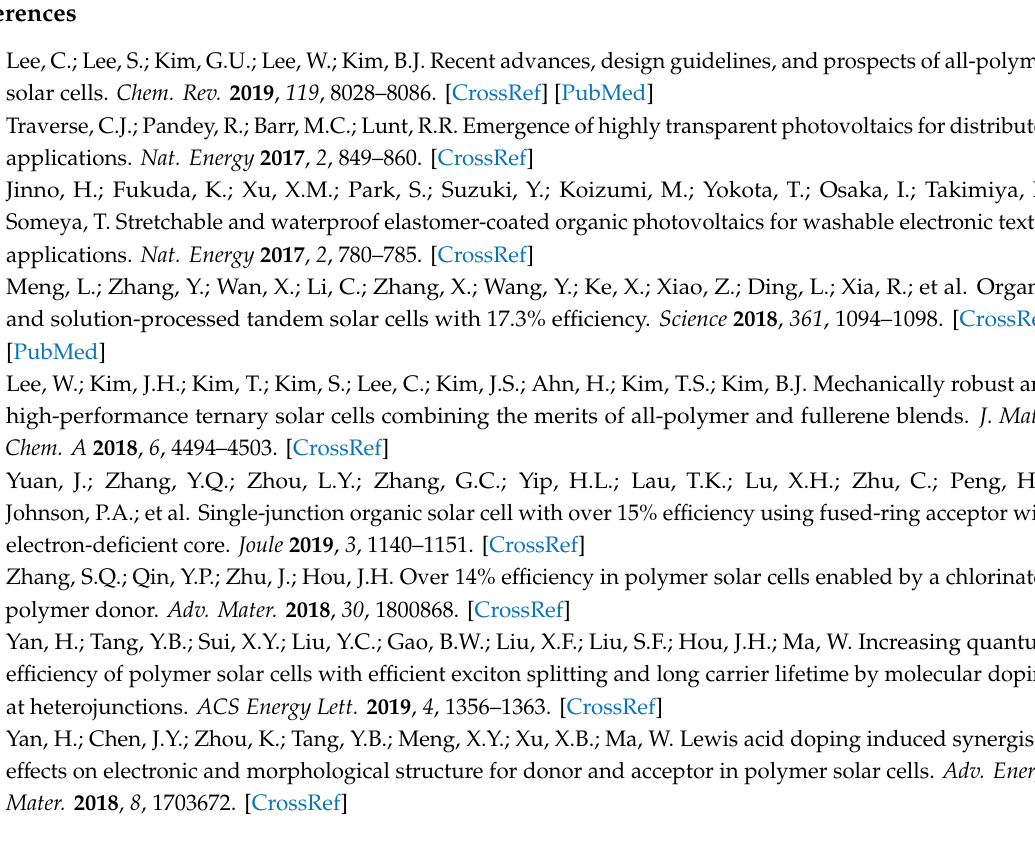
Figure S1: Absorption spectra of TQ1, PCE10, and PNDI-T10 neat films. Figure S2: Low and high energy parts of UPS spectra for neat TQ1 and PCE10 films under -10 V bias. Figure S3: Contact angle of TQ1, PCE10, and PNDI-T10 neat films. Figure S4: 5 µ m × 5 µ m AFM height and phase images of TQ1 / PCE10 / PNDI-T10 blend films without and with thermal annealing for di ff erent blend ratio. Figure S5: Coherence length and d-spacing of (100) and (010) peaks corresponding to 1D profiles in fig. 5g. Figure S6: GIWAXS of TQ1, PCE10, and PNDI-T10 neat films. Figure S7: hole-only devices and electron-only devices for the all-polymer blends with and without thermal annealing. Figure S8: Light intensity dependence of J sc and V oc based on TQ1 / PNDI-T10 = 2 / 1 and PCE10 / PNDI-T10 = 2 / 1